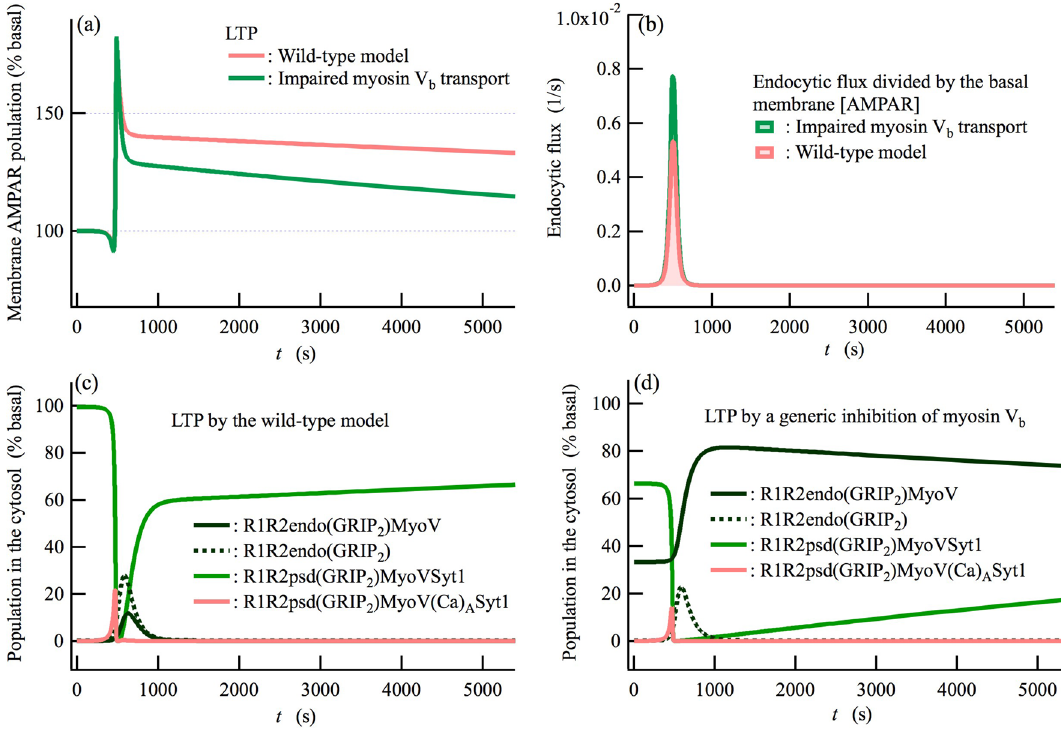
myosin V b transport 42 . ( b ) Normalized endocytic fluxes defined as the endocytic flux divided by the basal [AMPAR] at the membrane. ( c , d ) The populations of predominant components in the cytosol during LTP induction for ( c ) the wild-type model and ( d ) a model with inhibited myosin V b transport, shown as functions of time ( t ). Myosin V b -binding recycling endosome in the cytosol, [R1R2endo(GRIP 2 )MyoV], is increased under basal conditions by the inhibition of myosin V b transport, and furthermore is increased during impaired LTP induction, as seen in ( d